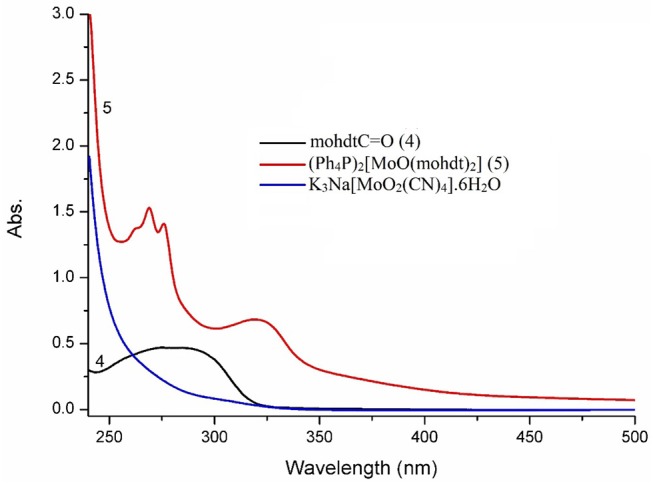
Comparison of UV-vis spectra of mohdtC=O (compound 4; λmax, nm (ε/M−1 cm−1): 211 (2682), 285 (br, 2340)), molybdenum precursor K3Na[MoO2(CN)4]·6H2O and the molybdenum complex 5 (λmax, nm (ε = M−1 cm−1): 225 (10653), 256 (sh, 2563), 265 (2758), 277 (2340), 323 (1023)) in acetonitrile solution.